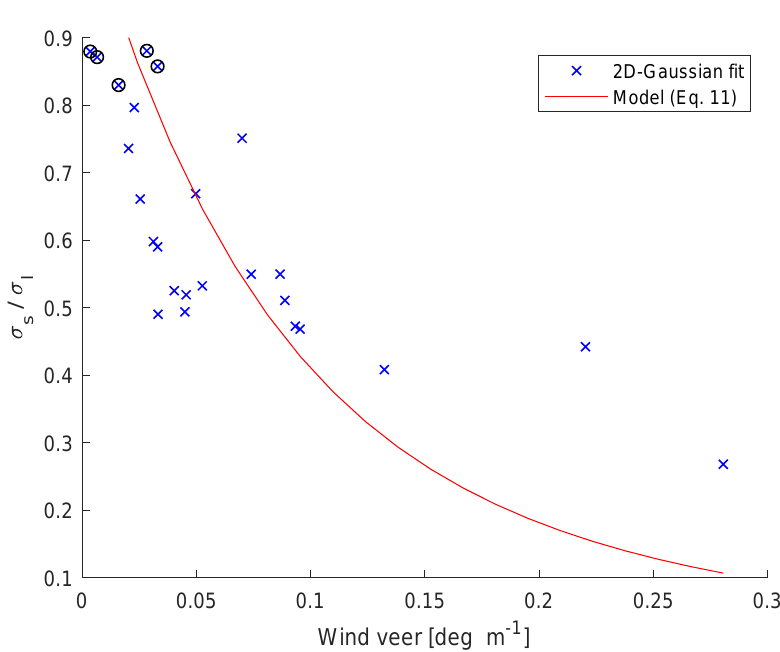
Figure 7. The mean ratio of the minor ( σ s ) to major ( σ l ) semi axis of the wake averaged for 4 ≤ x / D ≤ 8 as a function of the wind veer. Blue crosses show the measurements and the red line shows the wake model prediction (Equation (11)). Encircled crosses indicate data points where α rotated by 90 ◦ (see Appendix A).